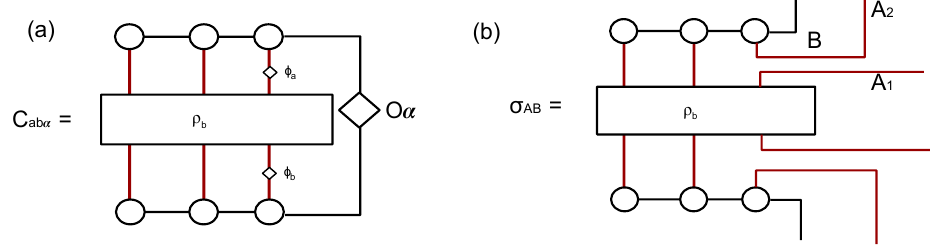
Figure 16. (a) Illustration of the bulk boundary correlator C ab(cid:11) in eq. (4.12). (b) The super- density operator that determines all bulk-boundary correlators involving region A and boundary B . Since we need to keep both (cid:30) a ; (cid:30) b on two side of (cid:26) b , the dimension of (cid:27) AB is D 2 D A D B when the Hilbert space dimension of A; B region are D A ; D B